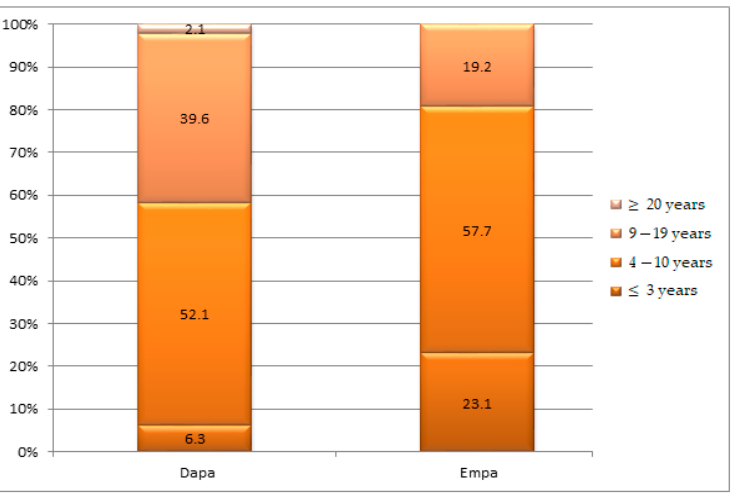
Figure 3. Group structures according to the age of diabetes in years.